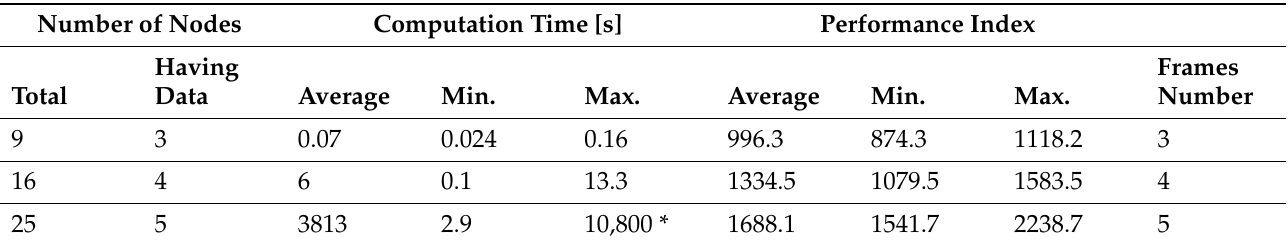
Table 3. Results for algorithm using total energy consumption index, (*) optimization of one of the frames for 25 nodes scenario was terminated after 180 min as computer memory was nearly exhausted, the maximum time and performance index values are related to this frame.